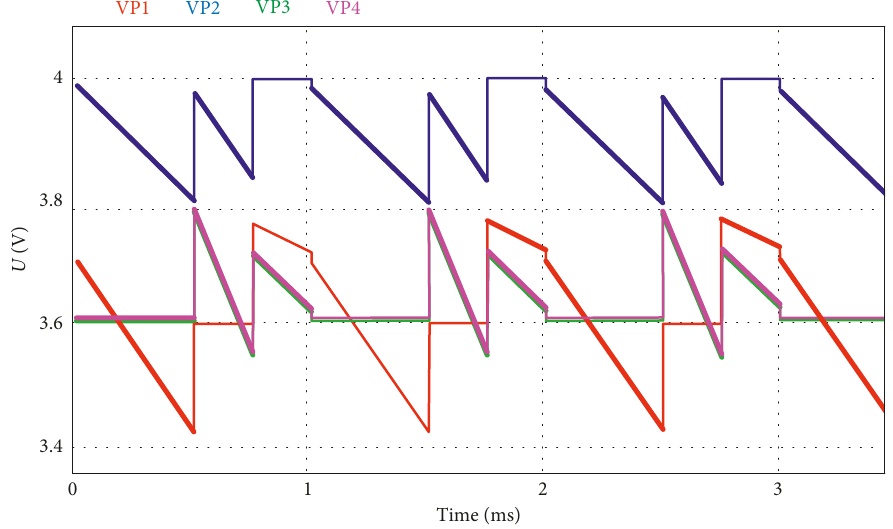
Figure 7: Battery pack voltage under HNFABC.